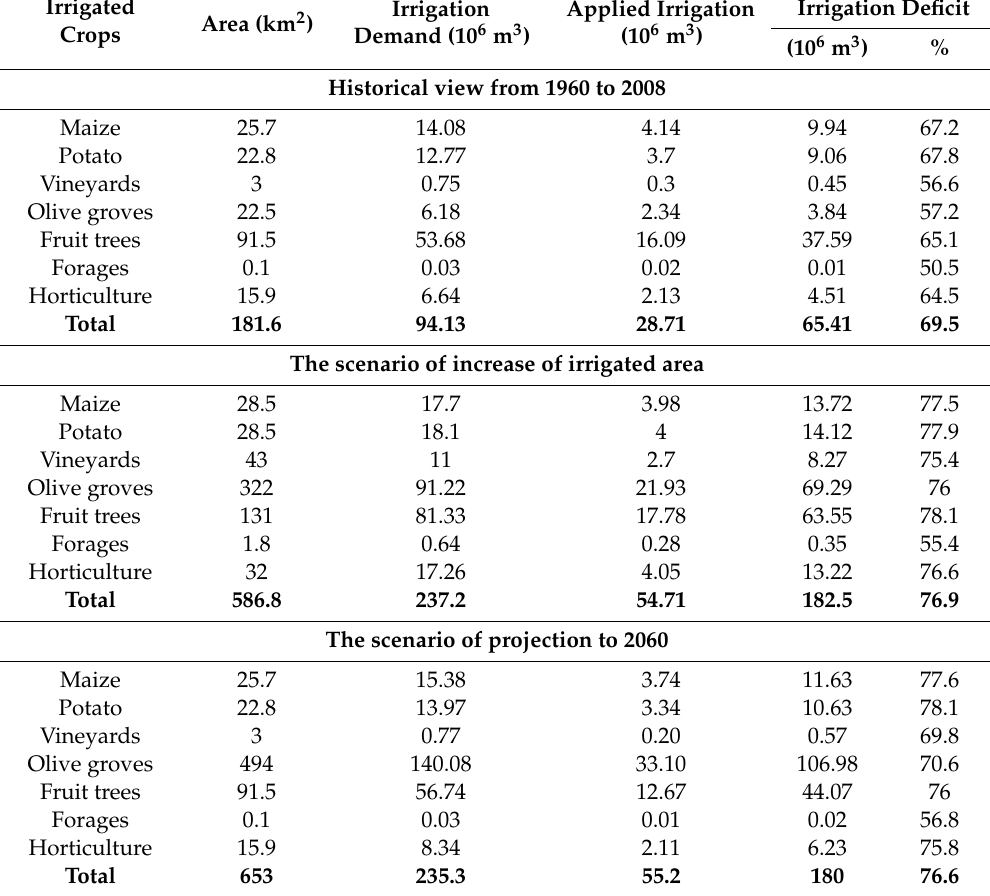
Table 8. The average annual irrigation demand, applied irrigation, and irrigation deficit per crop in the Sabor River Basin for the historical view (from 1960 to 2008) and for the two scenarios (an increase in the irrigated area and a projection to 2060). The scenario of an increase in the irrigated area represents the irrigation of the total irrigable area identified in COS2007